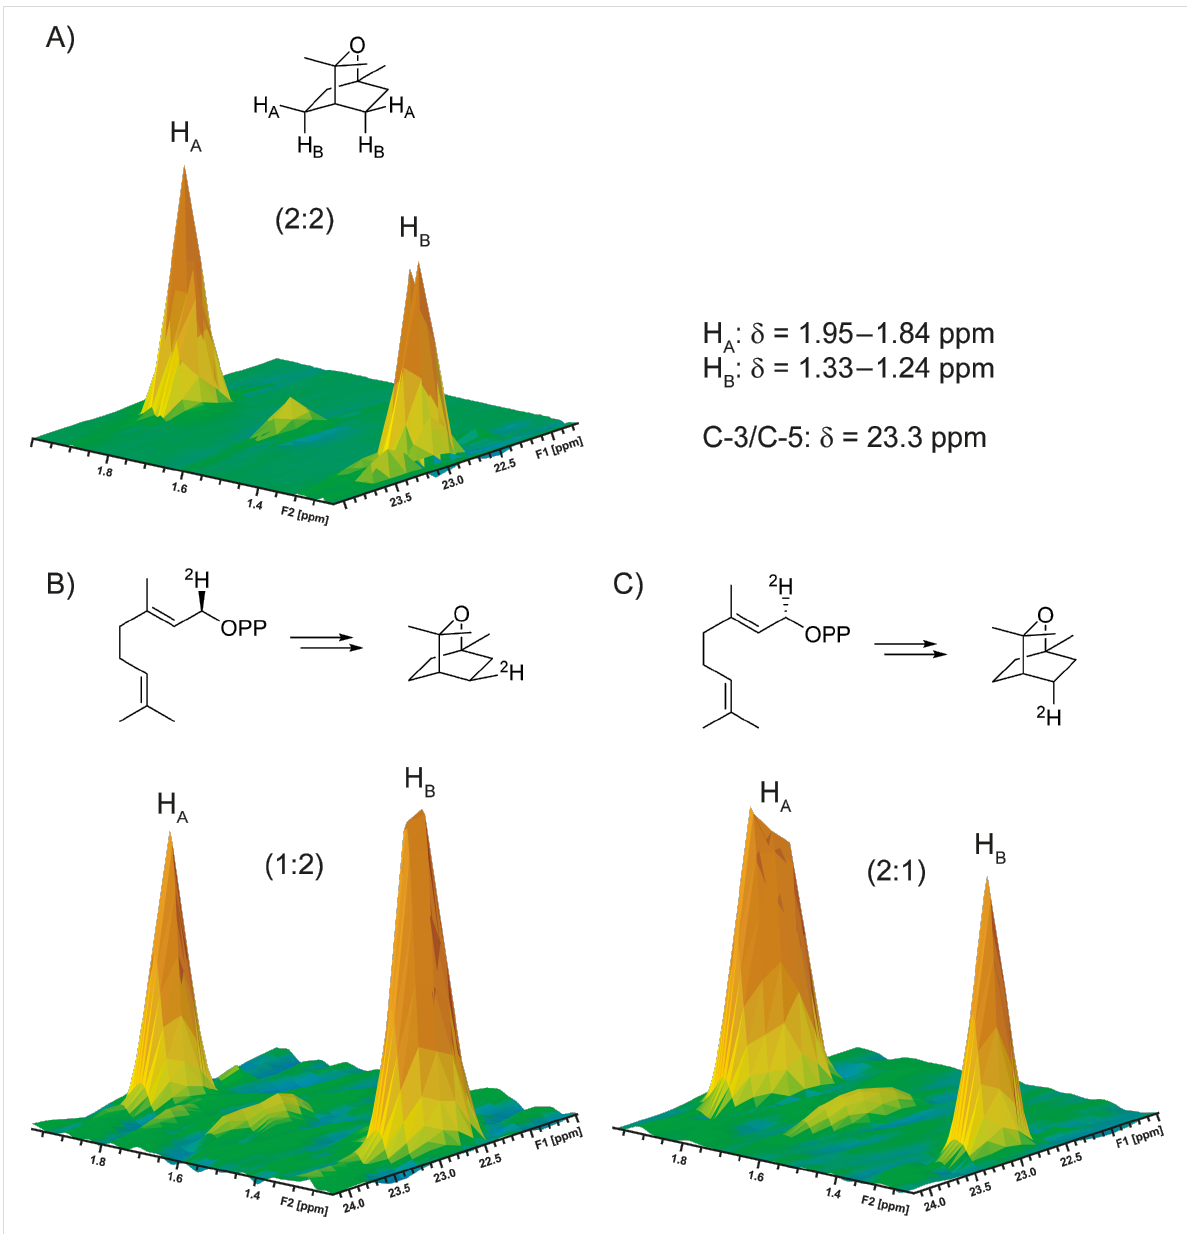
Figure 2: Partial HSQC spectra showing the region of crosspeaks for H A and H B connected to C-3 and C-5 of A) unlabelled 1 , B) ( 2 H)- 1 obtained by enzymatic conversion of ( R )-(1- 2 H)GPP, and C) ( 2 H)- 1 obtained by enzymatic conversion of ( S )-(1- 2 H)GPP. The indicated chemical shift data are for unlabelled 1 (for full data cf. Table S1, Supporting Information File